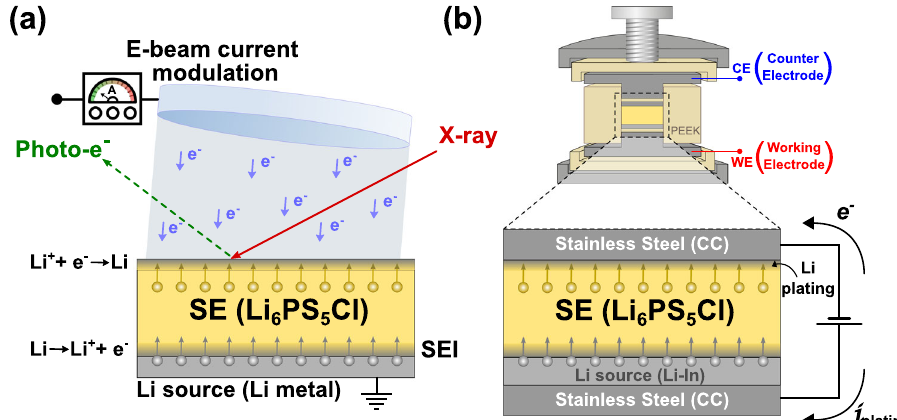
Fig. 1 | Schematic representation of lithium plating in XPS and a solid elec- trolyte cell with a lithium-free anode. Schematics depicting a the in situ XPS virtual electrode plating technique where the electron beam current can be modulated while acquiring photoemission spectra from the surface of the solid electrolyte (SE), and b the electrochemical setup in a lithium-free anode